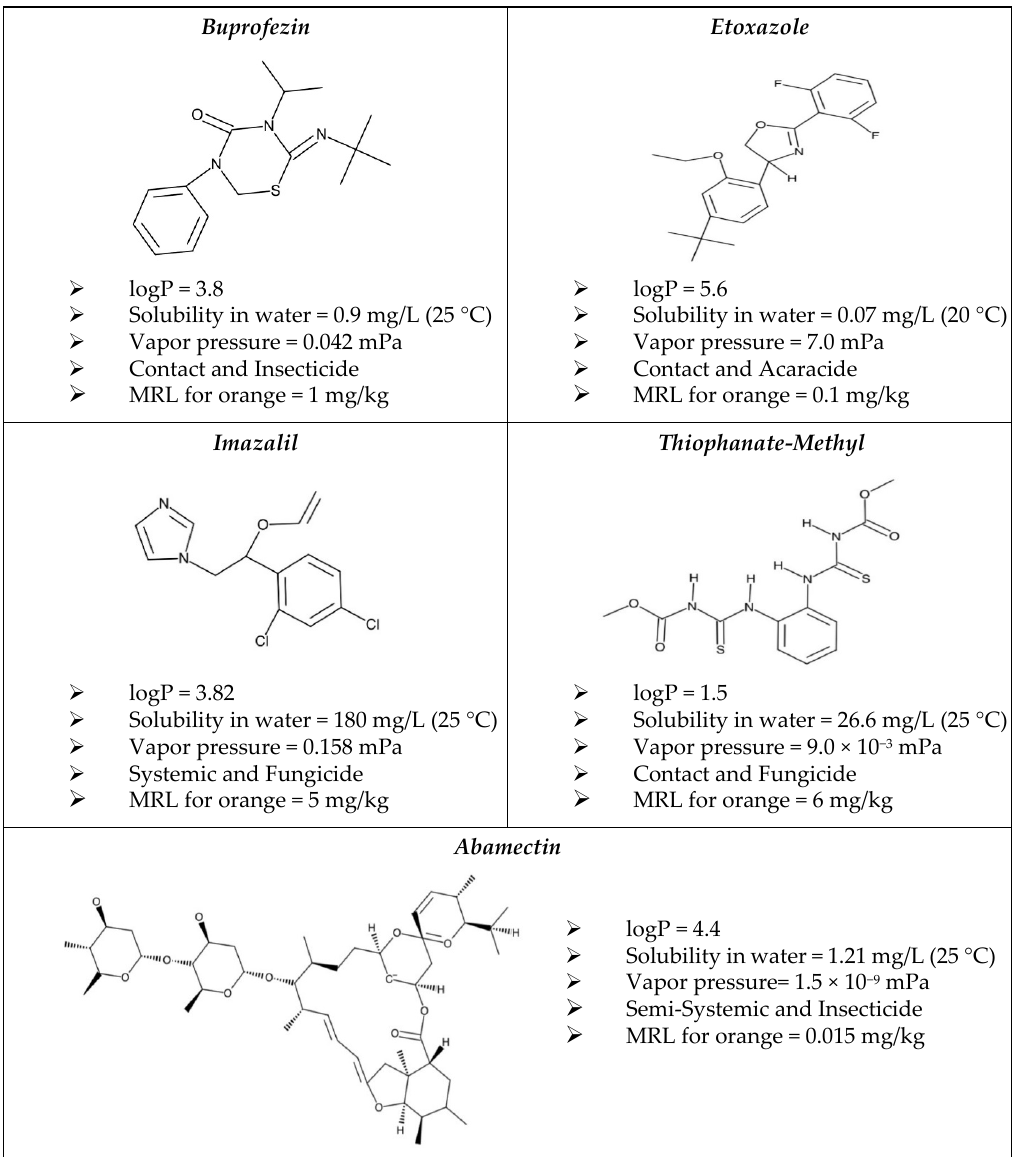
Figure 1. Physicochemical structure and mode of action for the active ingredient (pesticide). MRL represents maximum residue level (EC 2005).